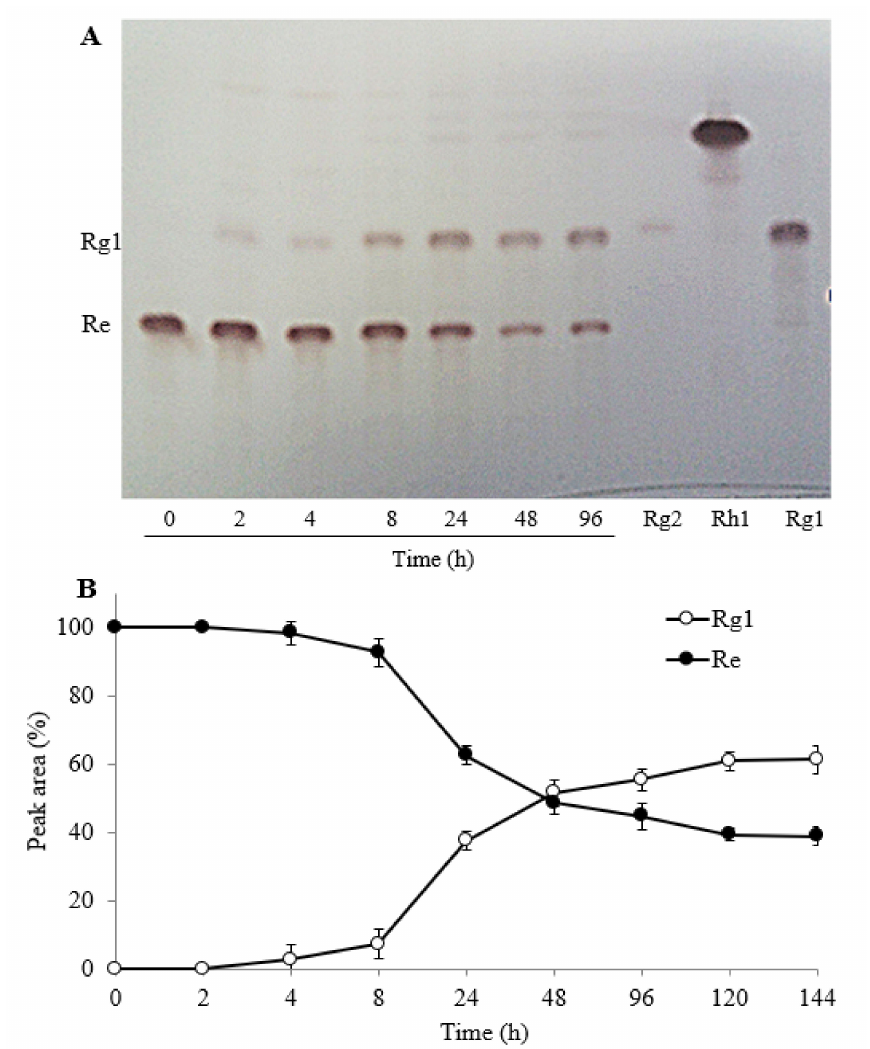
Figure 6. Time course of biotransformation of ginsenoside Re by FFEP. ( A ) TLC; ( B ) relative peak area percentage (%) of ginsenoside Re and Rg1 by HPLC